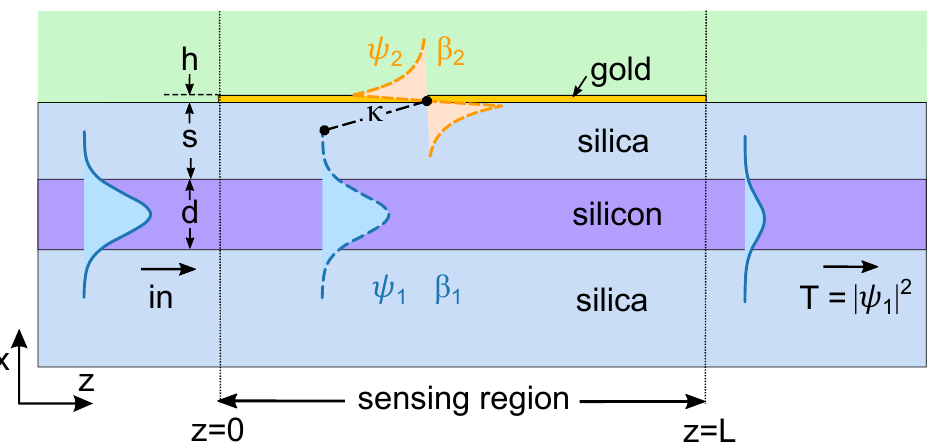
Figure 2. Schematic of the HPWG sensor and the coupled mode theory picture. The modes in the dielectric and plasmonic regions, ψ 1 and ψ 2 respectively, couple linearly as described by Equation (6). The power in the dielectric at output is given by T = | ψ 1 | 2 . The periodic exchange of power between waveguides can lead to a resonant spectrum that in general depends on both the length of the device L and the analyte index n a